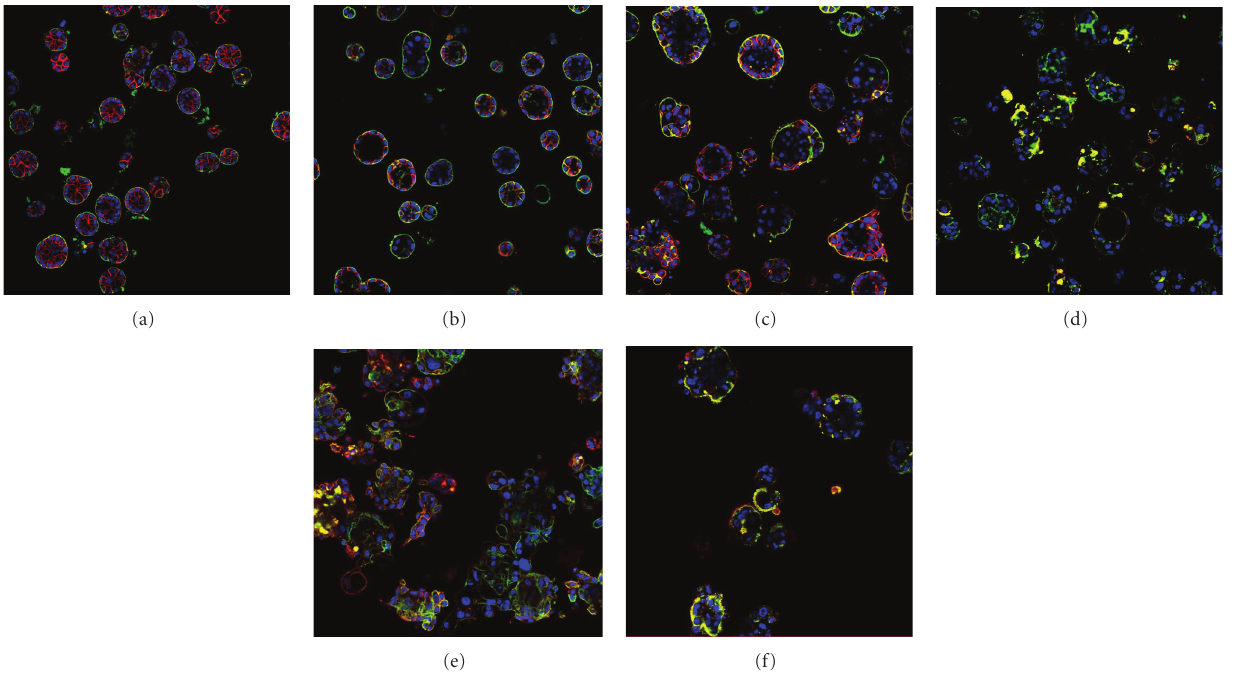
Figure 3: MCF10 series cell lines exhibit variation in acinar structure morphology along the metastatic cascade after 14 days in 3D laminin rich environment culture systems. Cells were cultured in 3D Matrigel suspensions and stained with integrin α 3 (red), integrin α 6 (green), and DAPI (blue). Example image slices from the six cell lines are typical of those captured during the course of the experiments and are displayed from (a) to (f) as follows: 10A, AT, KCL, DCIS, CA1H, and